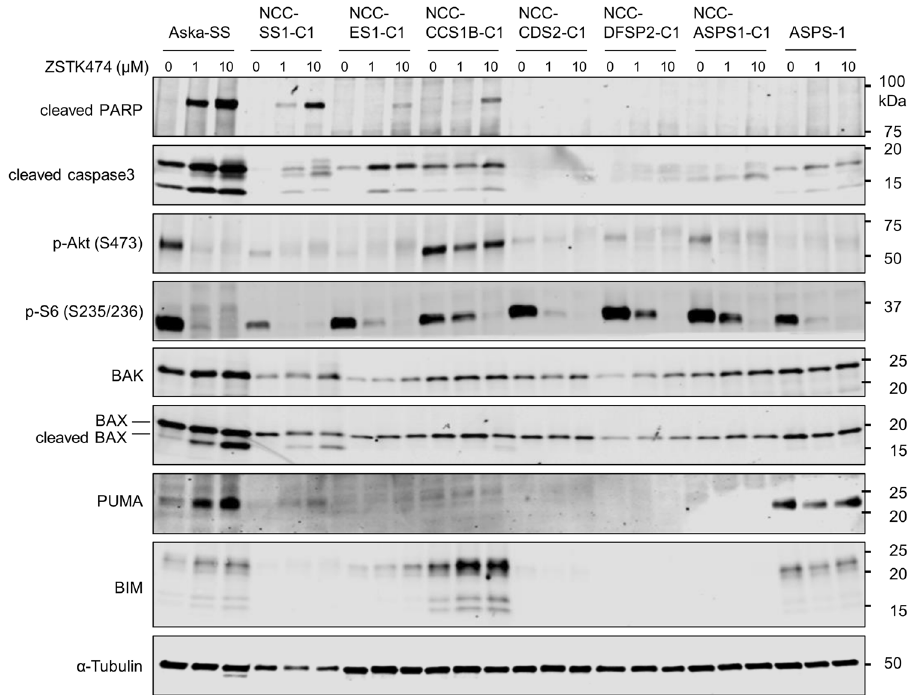
Fig. 6 Treatment with a PI3K inhibitor induced the expression of PUMA and/or BIM and the activation of BAK/BAX, thus leading to apoptosis in patient derived cells (PDCs) of TRSs. The effects of the PI3K inhibitor ZSTK474 on PI3K signaling, induction of apoptosis and the expression of proapoptotic BCL-2 family proteins in PDCs of TRSs including SS (NCC-SS1-C1), ES (NCC-ES1-C1), clear cell sarcoma (NCC-CCS1B- C1), CIC-DUX4 sarcoma (NCC-CDS2-C1), dermato fi brosarcoma protuberans (NCC-DFSP2-C1) and ASPS (NCC-ASPS1-C1). PDCs were treated with ZSTK474 at the indicated concentrations for 48 h. Lysed samples were immunoblotted to detect the phosphorylation of Akt (Ser473) and S6 (Ser235/236), cleavage of PARP, activation of caspase3 and the expression of BAK, BAX, PUMA, BIM and α